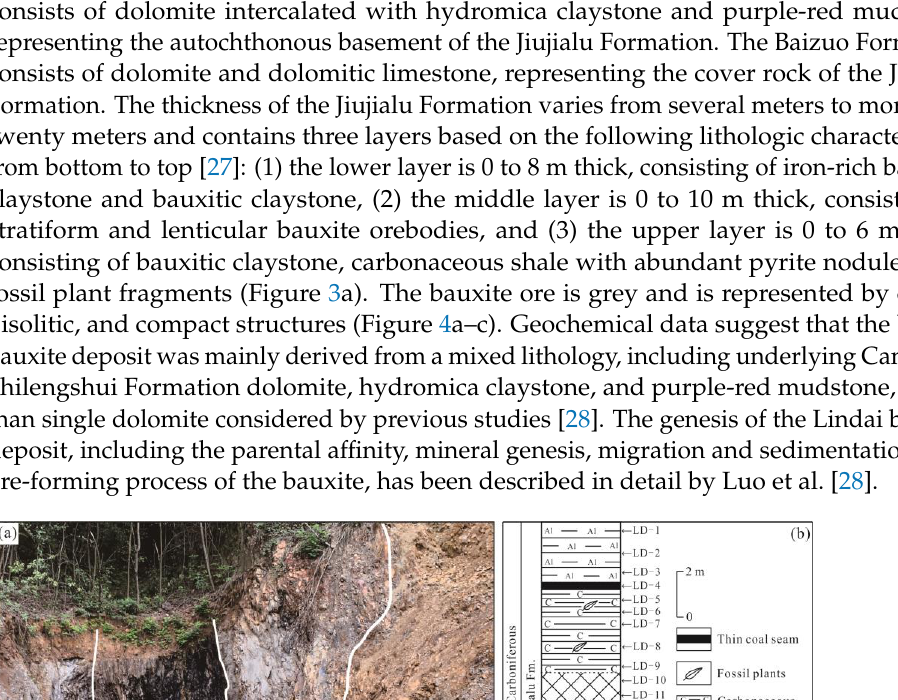
Figure 3. Field photograph and lithostratigraphic column of the Lindai bauxite deposit (modified from [28]). ( a ) The photograph shows the outcrop of the Lower Carboniferous Jiujialu Formation ore-bearing rock series. ( b ) Lithostratigraphic column and sampling location of the Lindai bauxite.